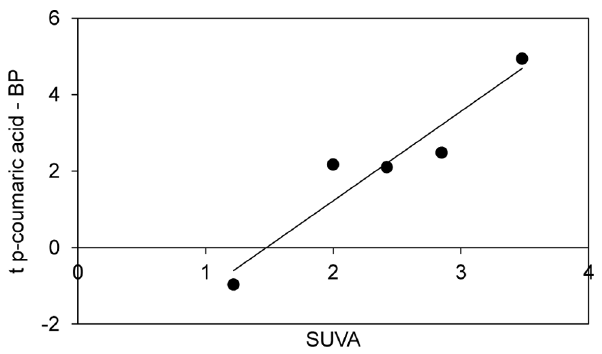
Figure 4. Association between SUVA and the relationship between functioning and the growth on p-coumaric acid. SUVA is the specific UV absorbance at 254 nm. Community functioning is assessed as per cell bacterial